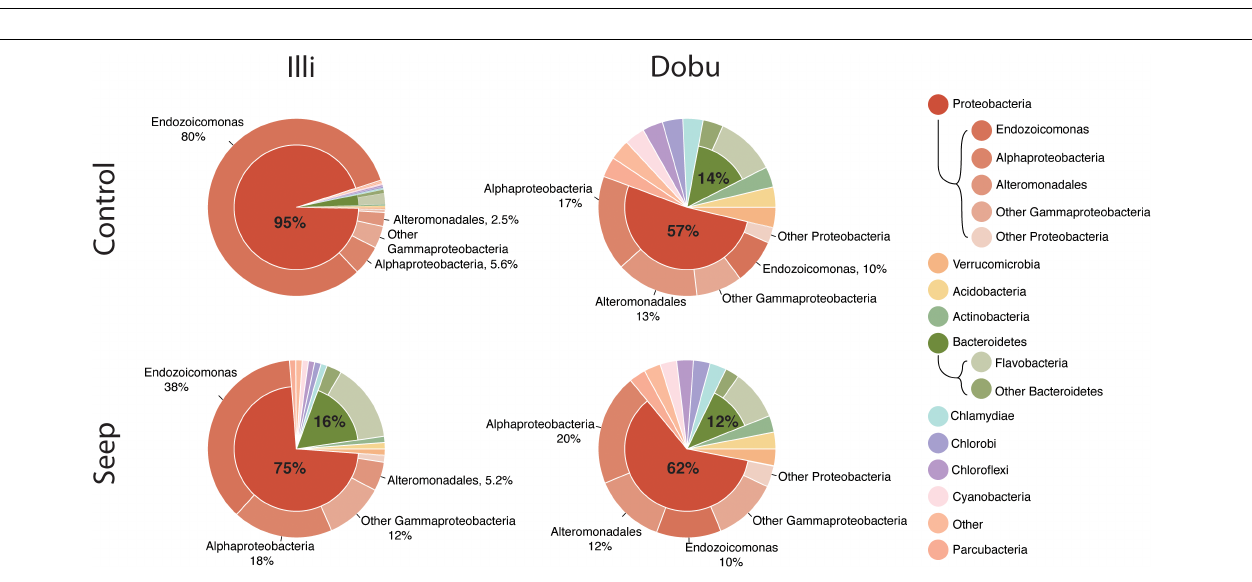
FIGURE 3 | Microbial community composition visualized using NMDS. Two colorations of the same plot are shown to visualize the effect of treatment (A) or reef (B) .